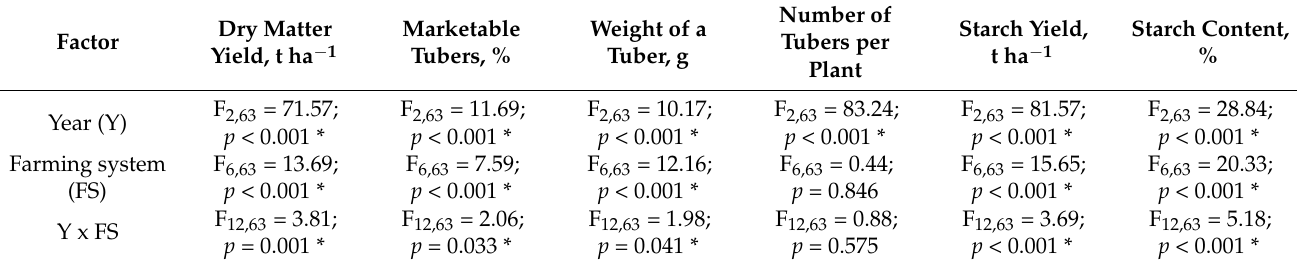
Table 2. Analysis of variance on the dry matter yield of tubers, marketable tubers, weight of a tuber, number of tubers per plant, starch yield and starch